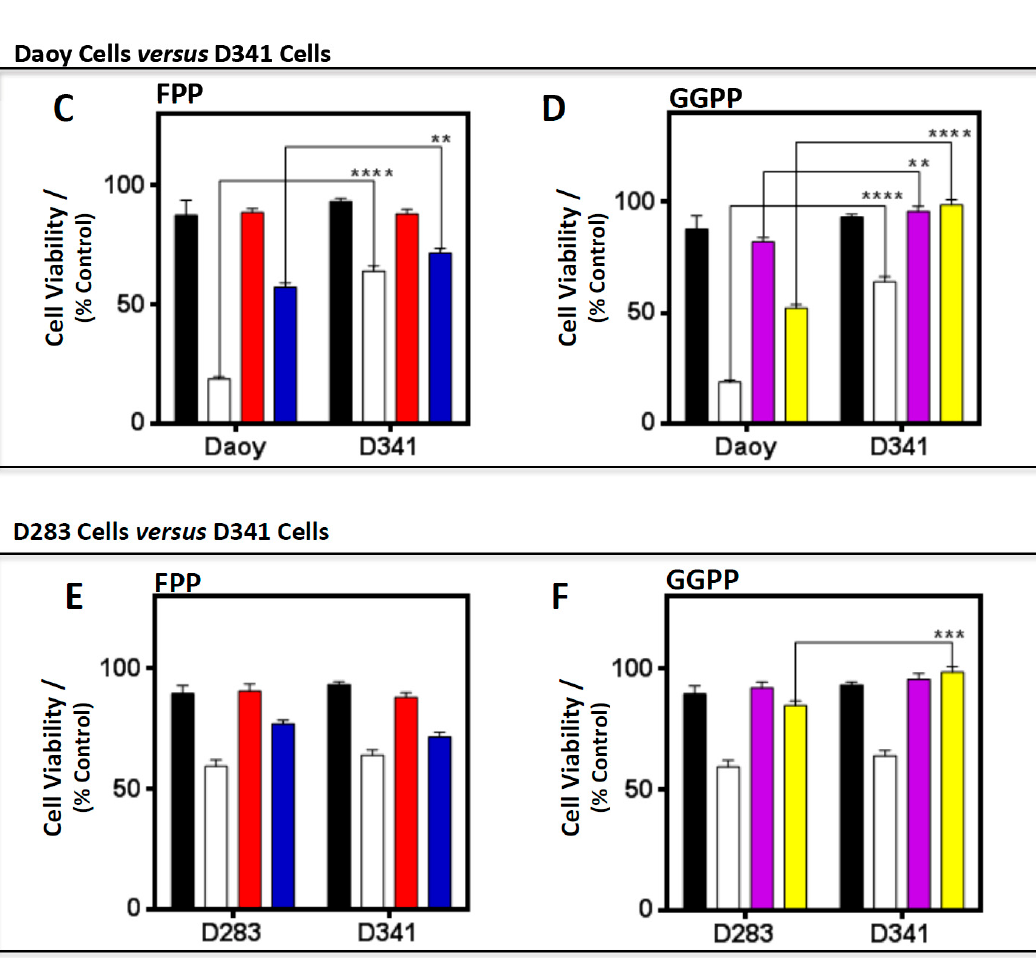
Figure 6. Farnesyl pyrophosphate (FPP) and gernaylgerany parophosphate (GGPP) have a cell line-specific response in medulloblastoma cell lines. Both FPP and GGPP levels were significantly reduced in Daoy cells compared to D283 ( A , B ) and D341 cells ( C , D ) when treated with simvastatin (5 µM) at 96 h. However, GGPP was observed to be significantly higher in D341 cells, when compared to Daoy cells, even under non-treatment conditions. Unlike Daoy versus D283 and D341, both FPP and GGPP levels remain unchanged between D283 and D341 under non-treatment conditions. Only GGPP was significantly reduced in D283 cells compared to D341 cells ( E , F ) when treated with simvastatin. Statistical significance was reported by two-way ANOVA using GraphPad Prism 6.0. p -value is reported as **** p < 0.0001, *** p < 0.001, or ** p < 0.01. Data are expressed as means ± SEM, and n = 15.